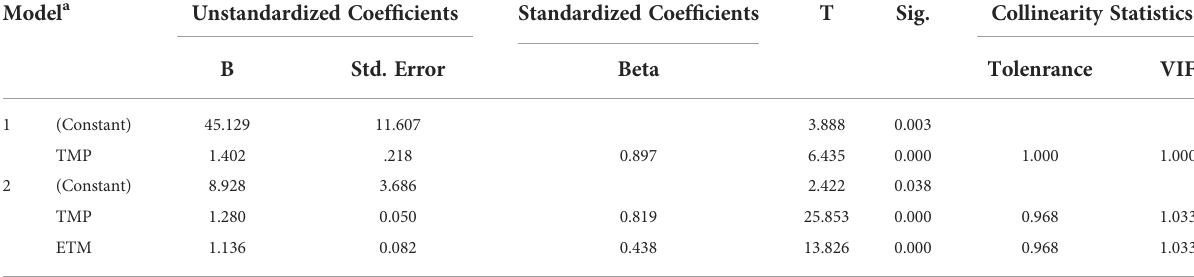
TABLE 3 The results of multiple linear regression analysis between antibiotics and environmental factors in water samples.